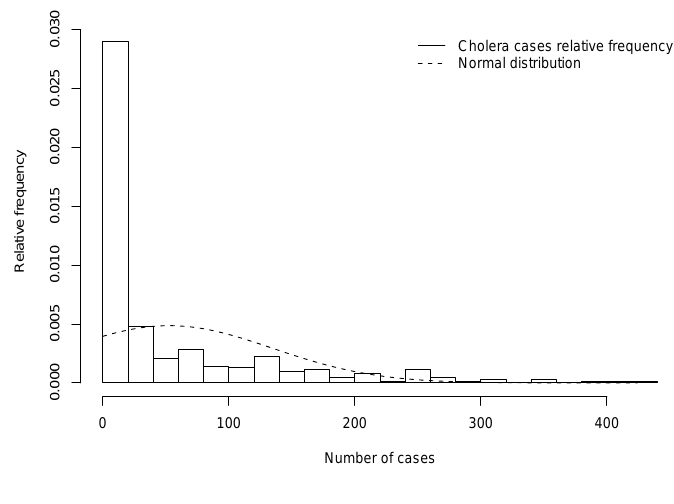
Figure 1: Histogram of cholera